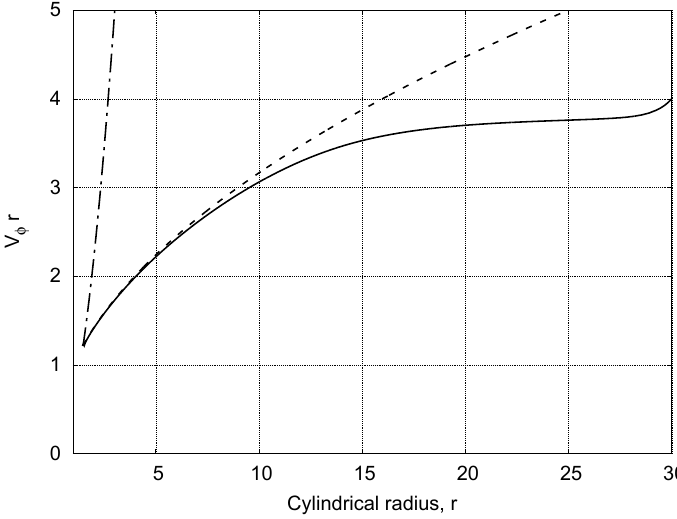
Figure 6. Distribution of the angular momentum of the flow at the equatorial plane (solid line). Dashed line—angular momentum at the Keplerian rotation and dashed-dotted line—angular mo- mentum at the rigid rotation. The equatorial flow at ω = 1.005 becomes Keplerian.